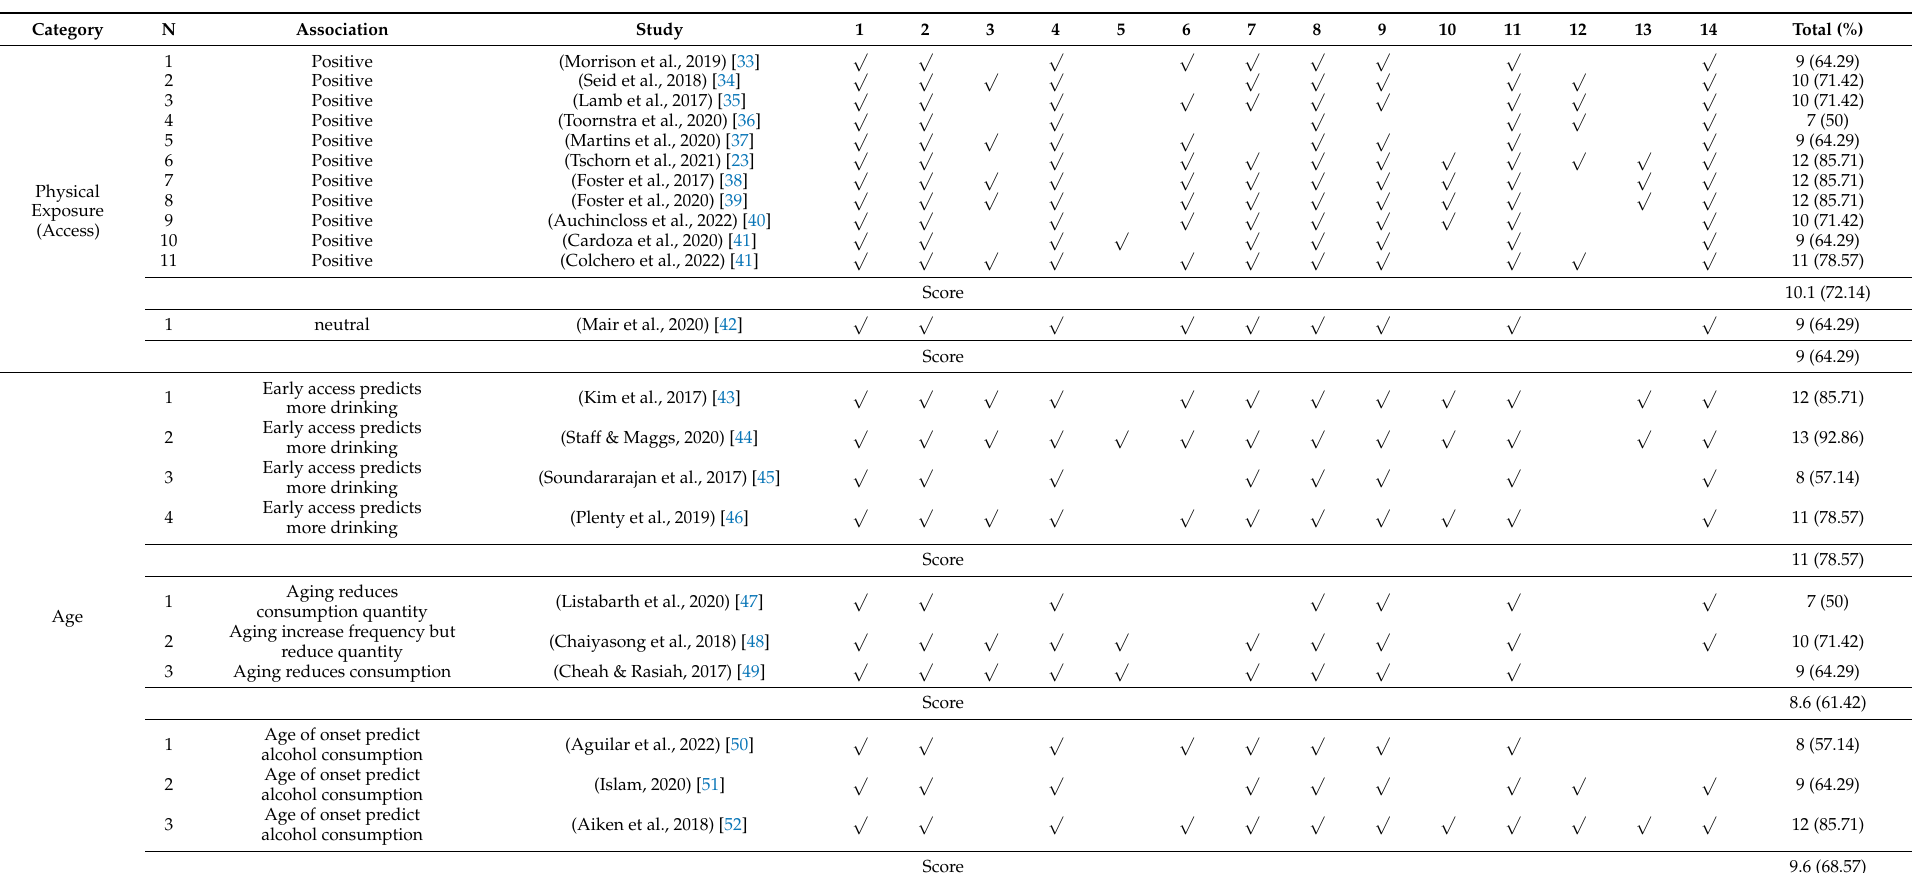
Table 1. Quality assessment of the observational